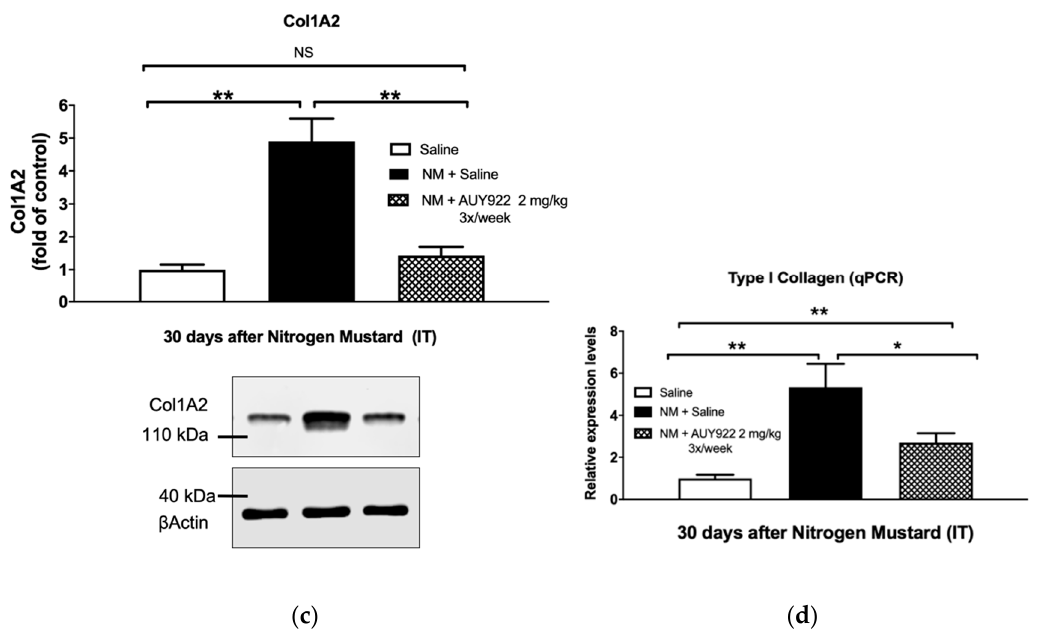
Figure 4. The HSP90 inhibitor, AUY-922, blocks the NM-induced collagen production. Total collagen protein and mRNA in lung tissue homogenates was determined by Western blotting ( a , c ) and real time qPCR ( b , d ), respectively, as described in the Methods. Mice received 0.625 mg/kg of NM or saline (2 μ L/g body weight, intratracheally) on day 0. They then received AUY-922 (1 mg/kg, 2×/week ( a , b ) or 2 mg/kg, 3×/week ( c , d ) intraperitoneally) for 30 days, starting 24 h after NM. Means ± SEM; n = 4 mice per group; *: p < 0.05, **: p < 0.01, NS: not significant with ANOVA and Turkey’s.